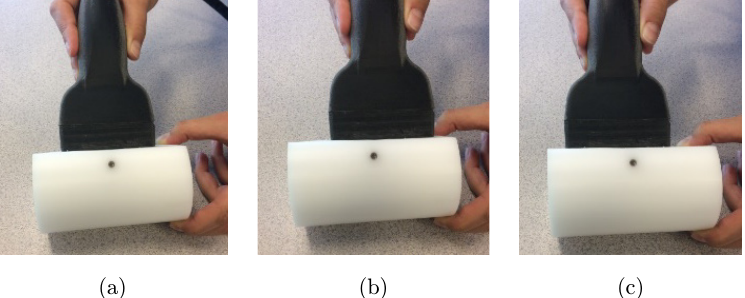
Fig. 5. DOB-Scan probe in three di®erent locations on the phantom. The center line of the probe is aligned: (a) with the center of the hole, (b) 7 mm left to the hole, (c) 7 mm right to the